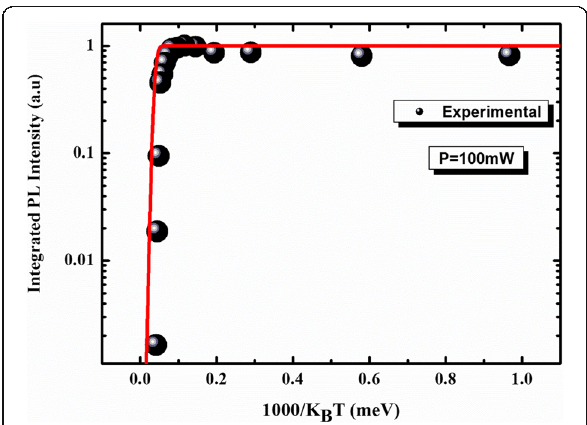
Fig. 11 Arrhenius fitting of the investigated sample. The normalized integrated intensity ( black circles ) is fitted with three activation energies ( red solid line )